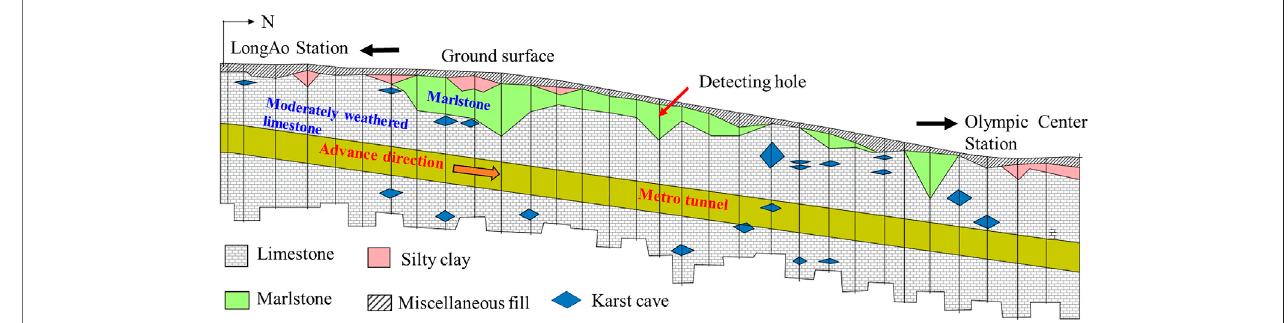
FIGURE 2 | Geological pro fi le of detected Karst formation along R3 Line.